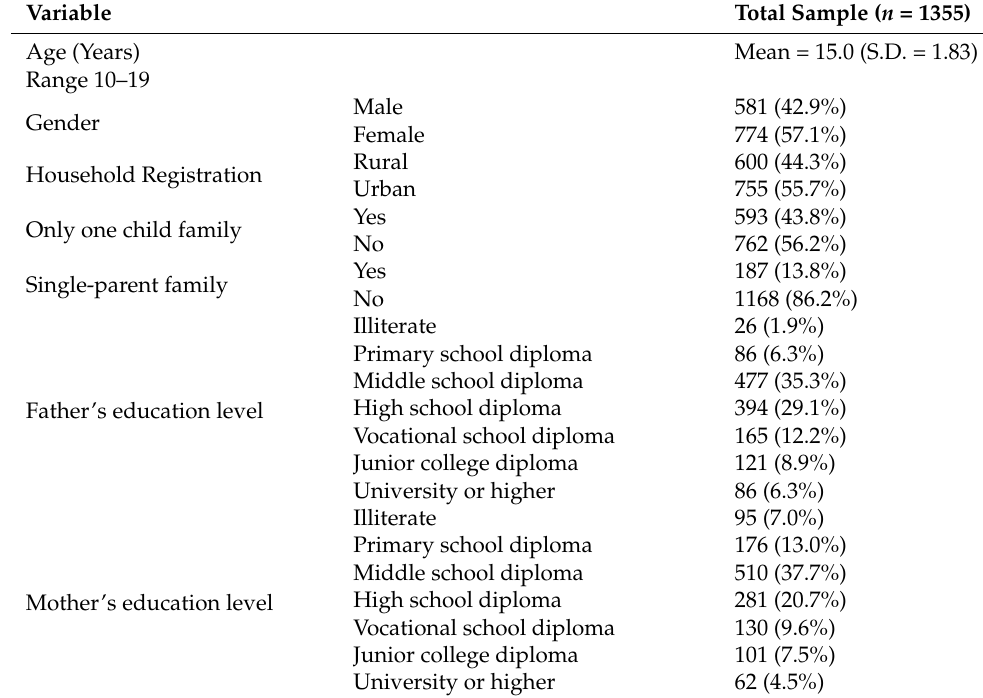
Table 1. Demographic characteristics of the